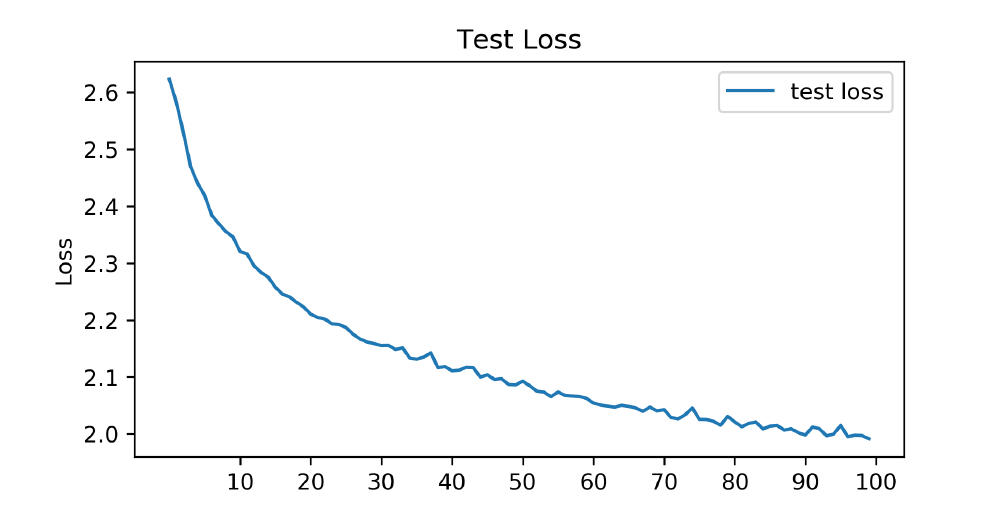
Figure 4. ViT: Adam training test loss. Table 3. ViT accuracy per